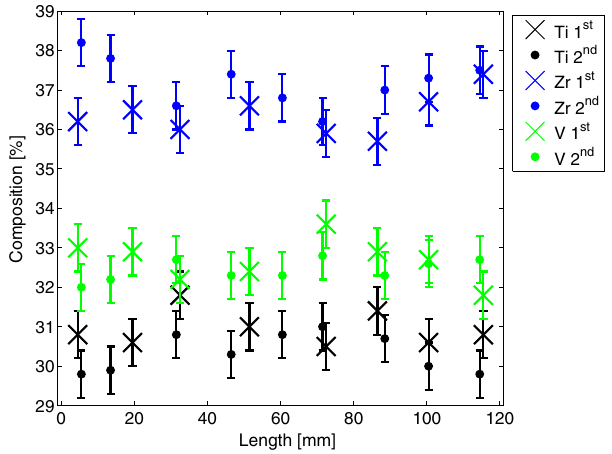
FIG. 5. Measurements of the NEG coating composition on the two copper slabs used for the experiments.